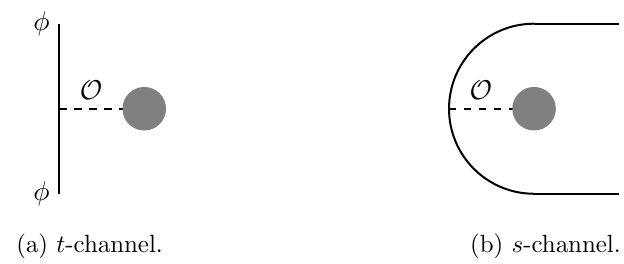
Figure 5. An illustration of the relation between s - and t -channels in the h (cid:30)(cid:30) i (cid:12) correlator. The two channels are related by moving the external operators around the thermal circle (gray). A single term in the t -channel OPE O 2 (cid:30) (cid:2) (cid:30) inverts to the sum over the [ (cid:30)(cid:30) ] n families in the s -channel. Alternatively, the sum over the [ (cid:30)(cid:30) ] n families in the s -channel reproduces the O term in the t